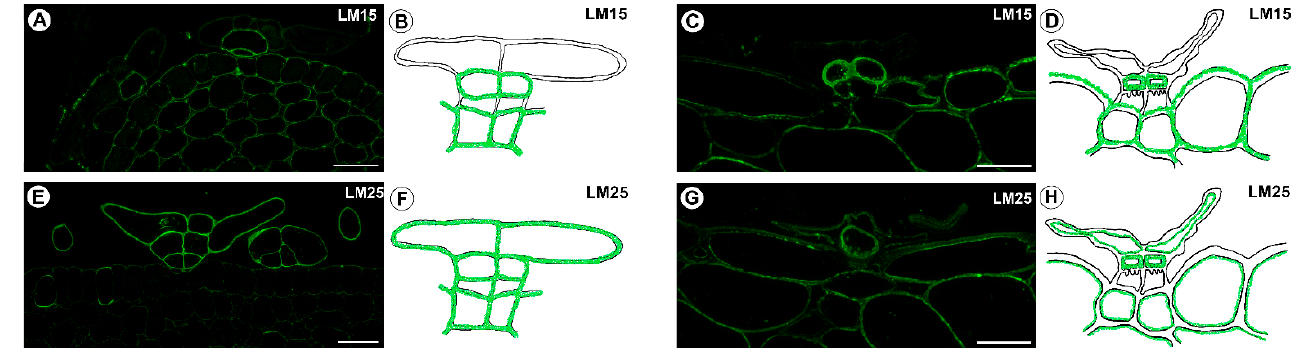
Figure 6. Xyloglucan that was detected in the stellate trichomes of the Dionaea muscipula traps. ( A ) Xyloglucan (labeled with LM15) that was detected in the young trichomes, bar 20 µm. ( B ) Schematic occurrence (green) of the xyloglucan (labeled with LM15) that was detected in a young trichome. ( C ) Xyloglucan (labeled with LM15) that was detected in a mature trichome, bar 20 µm. ( D ) Schematic occurrence (green) of the arabinogalactan proteins (labeled with LM15) that were detected in a mature trichome. ( E ) Xyloglucan (labeled with LM25) that was detected in the young trichomes, bar 20 µm. ( F ) Schematic occurrence (green) of the xyloglucan (labeled with LM25) that were detected in a young trichome. ( G ) Xyloglucan (labeled with LM25) that was detected in a mature trichome, bar 20 µm. ( H ) Schematic occurrence (green) of the xyloglucan (labeled with LM25) that was detected in a mature trichome.